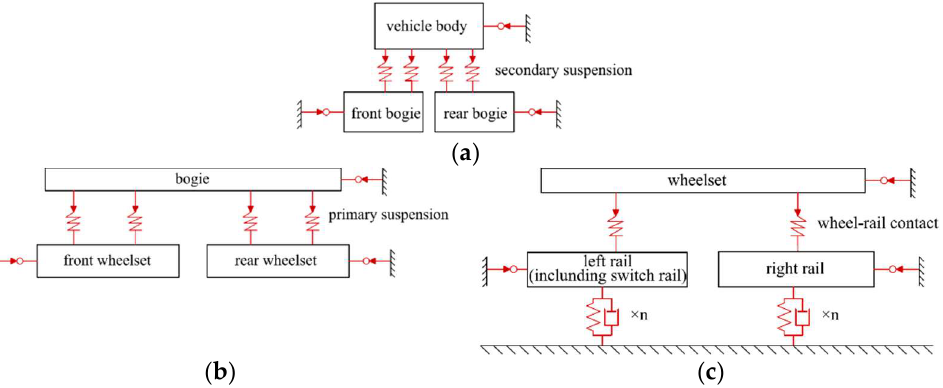
Figure 1. The topological graph of the model. ( a ) Structure of the vehicle; ( b ) substructure—bogie; ( c ) substructure—wheelset.